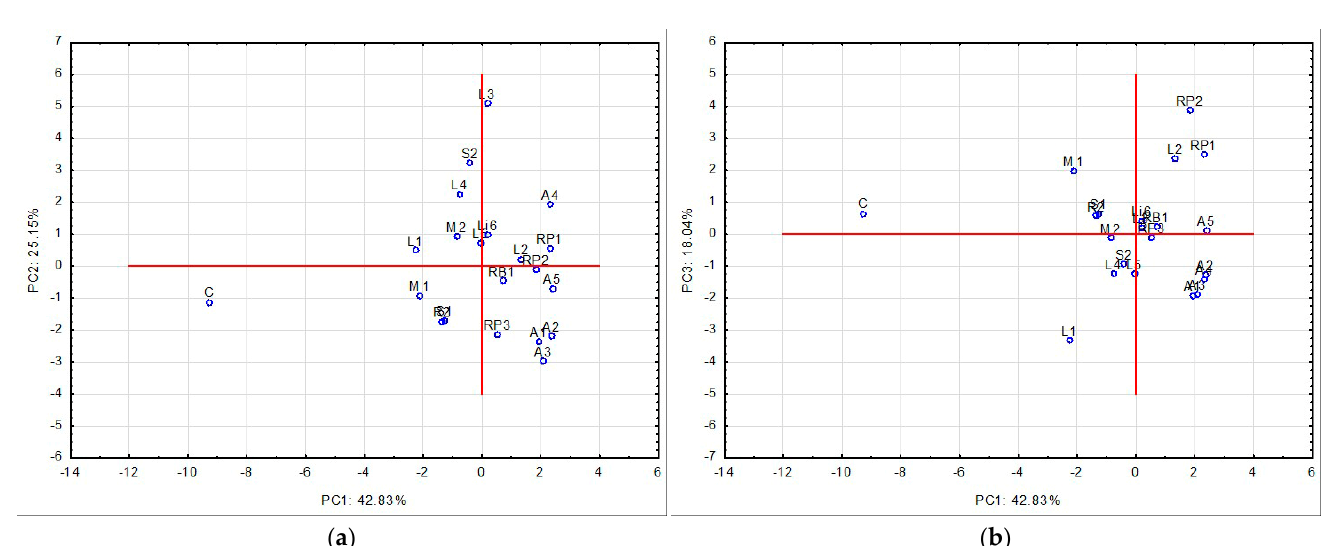
Figure 5. Graphical representation of PC for the analyzed honey samples: ( a ) scores for PC2 vs. PC1 and ( b ) scores for PC3 vs. PC1.